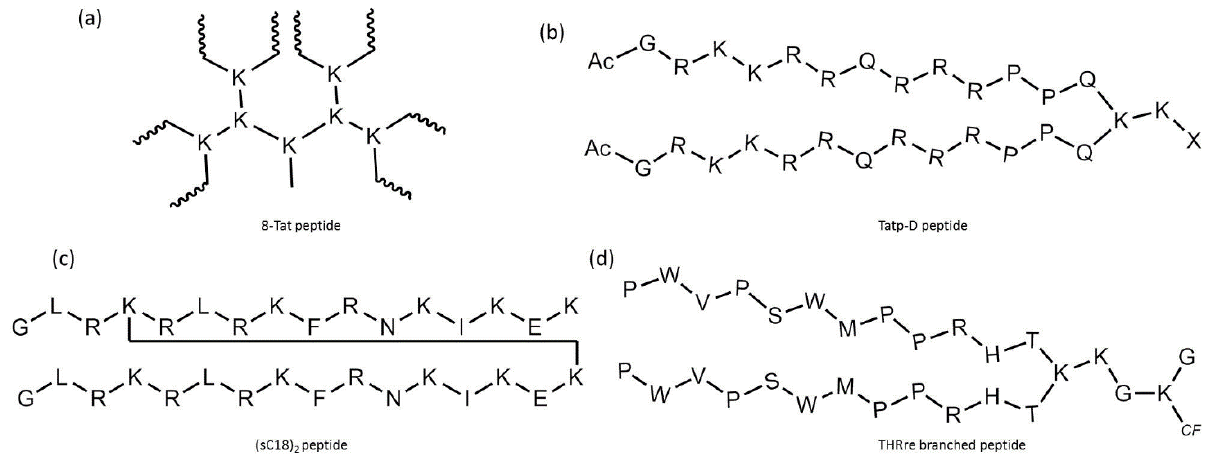
Figure 4. Branched peptides derived from classic linear CPPs. ( a ) the structure of 8-Tat peptide, ( b ) structure of Tatp-D peptide, ( c ) structure of (sC18) 2 peptide and ( d ) the structure of THRre branched peptide.